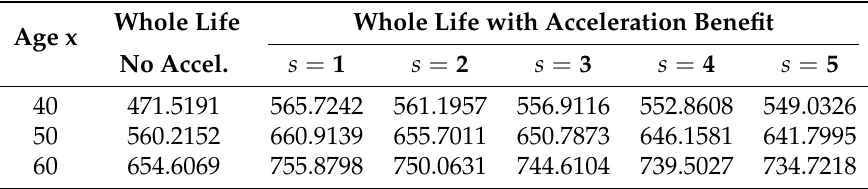
Table 5. Product P2 (whole life assurance with LTC acceleration benefit); single premiums Π [ P2 ( s )] = and Π x ; C